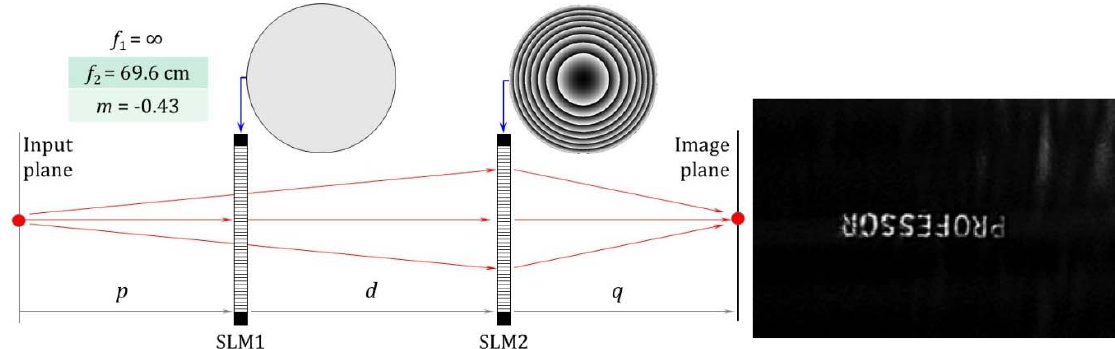
Figure 5. Zoom system configuration with f 1 = ∞ and f 2 = +69.6 cm and experimental image with magnification of m = − 0.4.